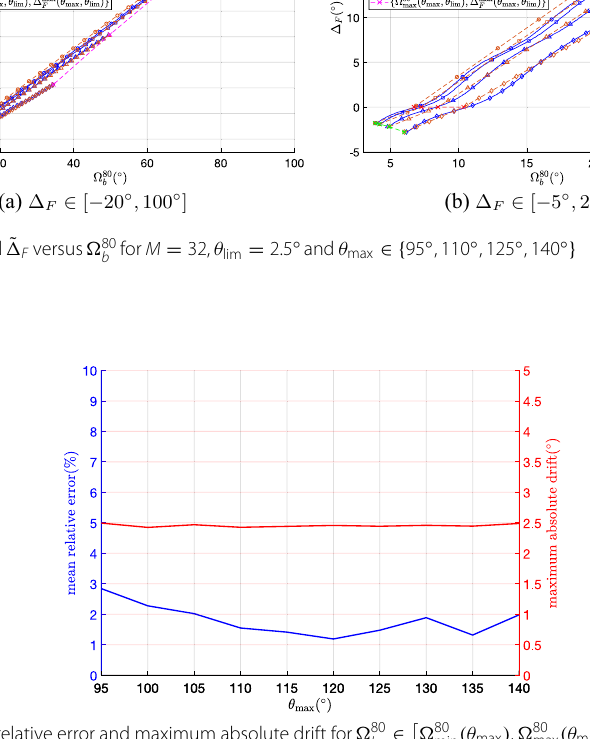
Fig. 13 Mean relative error and maximum absolute drift for � 80 b